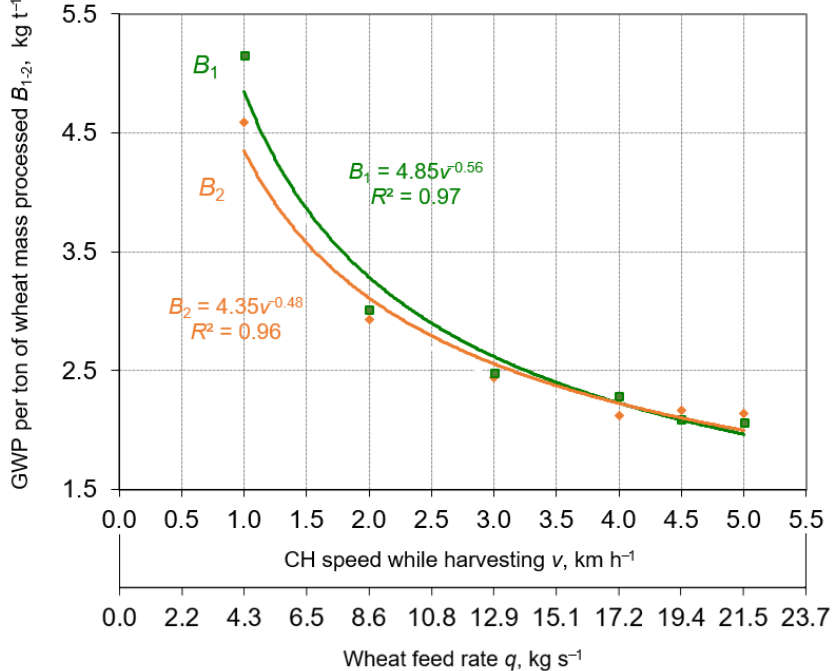
Figure 3. Relation between combine harvester (CH) speed in harvesting mode and global warming potential (GWP) per ton of wheat mass processed in the 2019 tests (engine crankshaft speed n = 2200 min – 1 ): B 1 —threshing cylinder rotational speed nt = 950 min – 1 B 2 — nt = 850 min – 1 The value of each n = 2200 min − 1 ): B 1 —threshing cylinder rotational speed nt = 950 min − 1 B 2 — nt = 850 min − 1 The point was obtained from an average of 20 replicates. value of each point was obtained from an average of 20